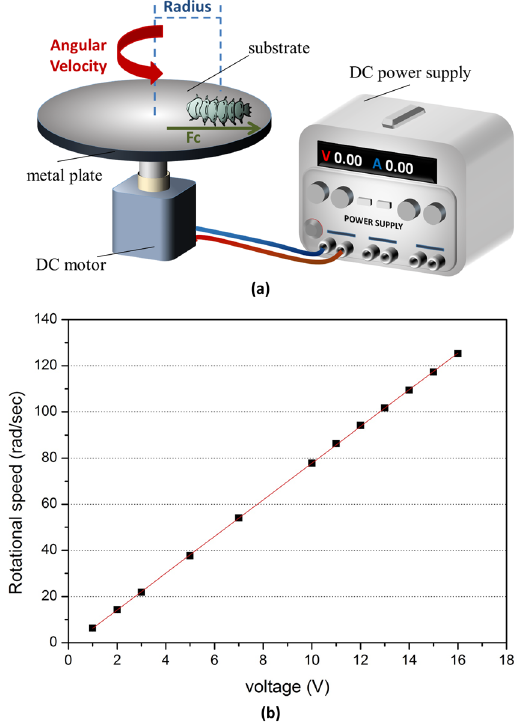
Figure 6. ( a ) Illustration of centrifugal measurement method showing the apparatus of centrifugal measurement is connected to a DC power supply with a metal plate that can be covered by different sand paper, and a DC motor that can rotate the plate. ( b ) The dependence of the rotational velocity of the motor on the applied voltage. The rotational velocity is directly proportional to the applied voltage which can be read on the DC power